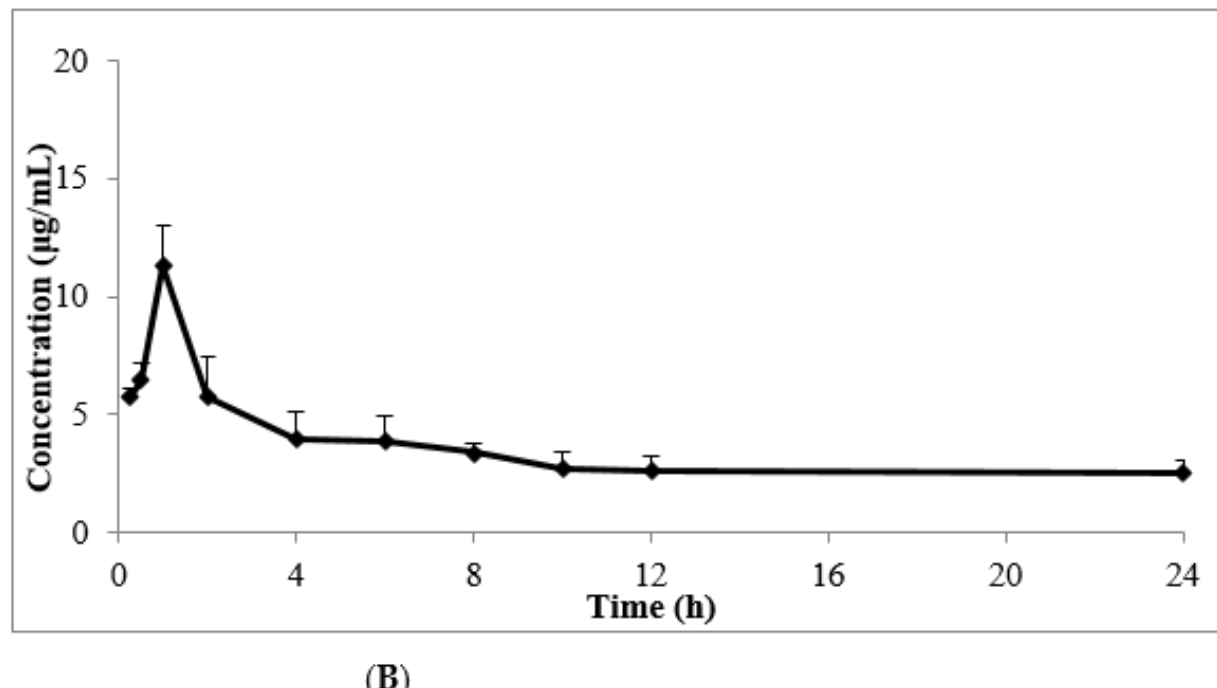
Figure 8. The mean drug–time curves of skin tissues after topical administration of CE-NE ( A ) and ointment ( B ) in KM mice. ( n = 5).